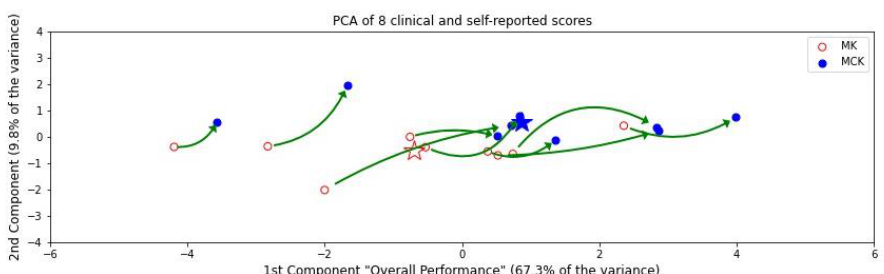
Figure 3. The first principal component, represented by the X-axis, accounts for 67.3% of the variation in scores among these subjects. This axis also corresponds to the improvements in all 8 measures as the subjects move along the X-axis. The Y-axis only accounts for the remaining 9.8% and was only included as an additional dimension for visualization. Stars indicate the mean values for each de- vice. Table 3. Load factors for the first PCA component used as the X-axis in Figure 3.